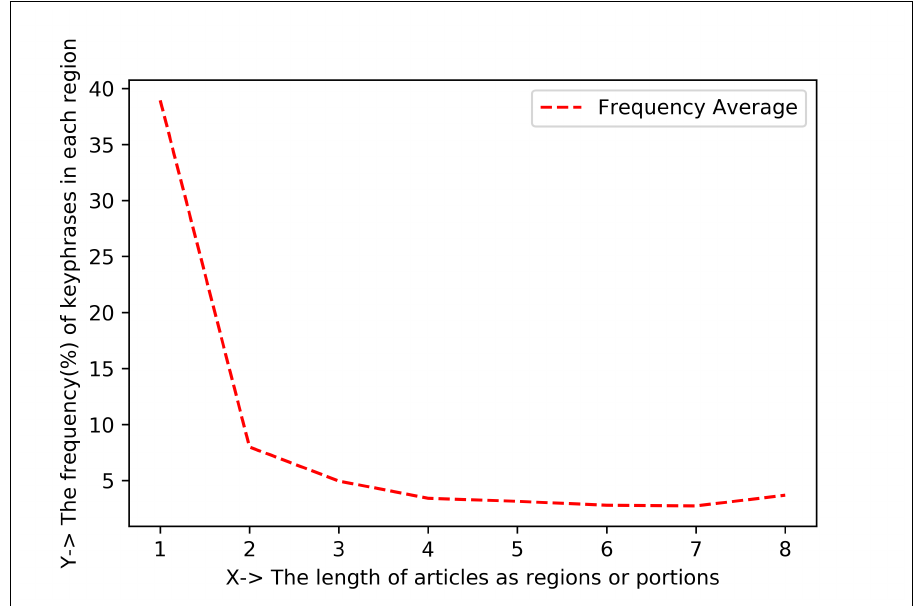
Figure 10. The analysis of Avg weighted frequency of all datasets in percent (%) using same consider- ation for KCFA